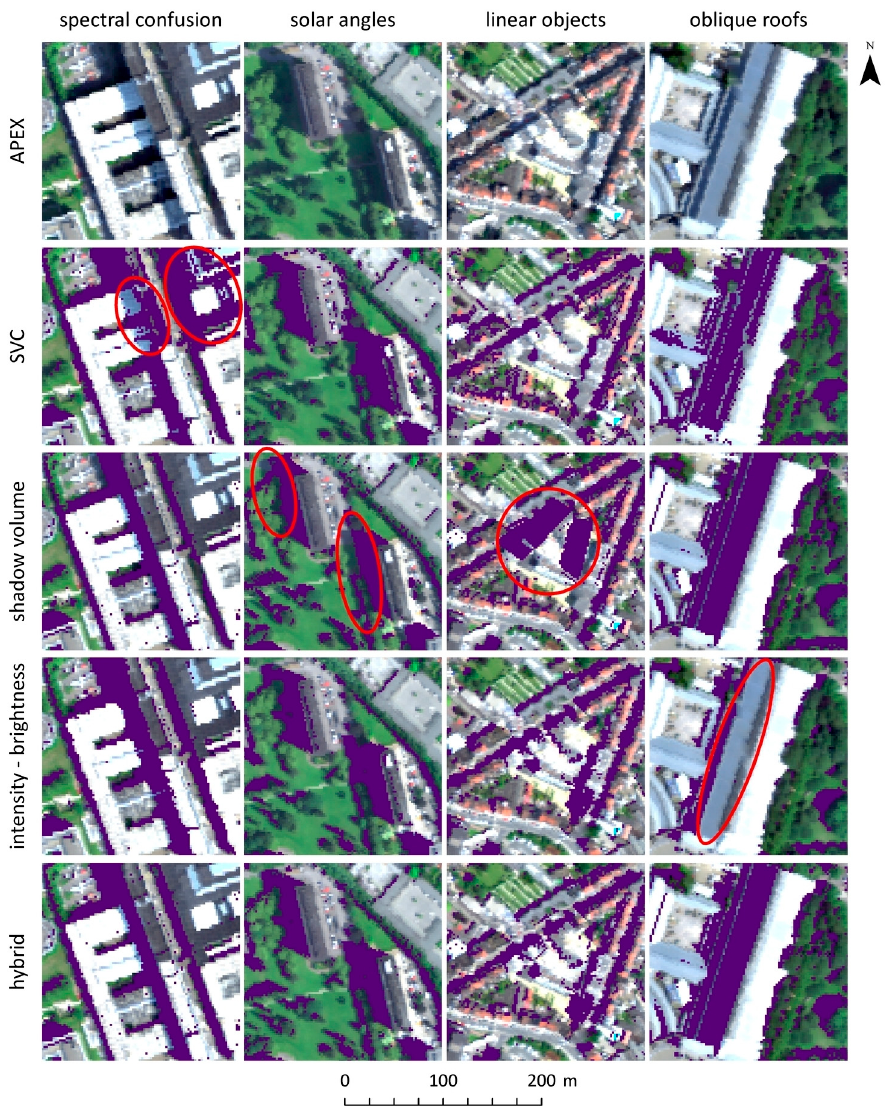
Figure 7. Results of the four shadow detection approaches (detected shadow shown in purple) applied in this research for a selection of APEX subsets illustrating strengths and weaknesses of each approach. The first row depicts the subsets without shadow mask as visual reference. A number of typical errors are highlighted in this figure.